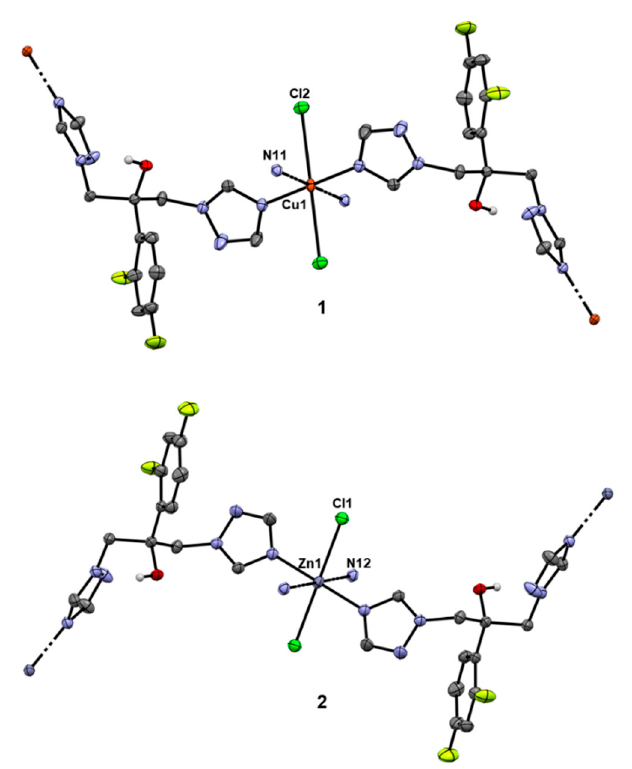
Figure 3. Crystal structures of complexes 1 and 2 . Thermal ellipsoids are presented at a 35% probability level. Solvent molecules are omitted and only hydrogen atoms on the oxygen atoms of fluconazole ligands are displayed for better clarity of presentation.